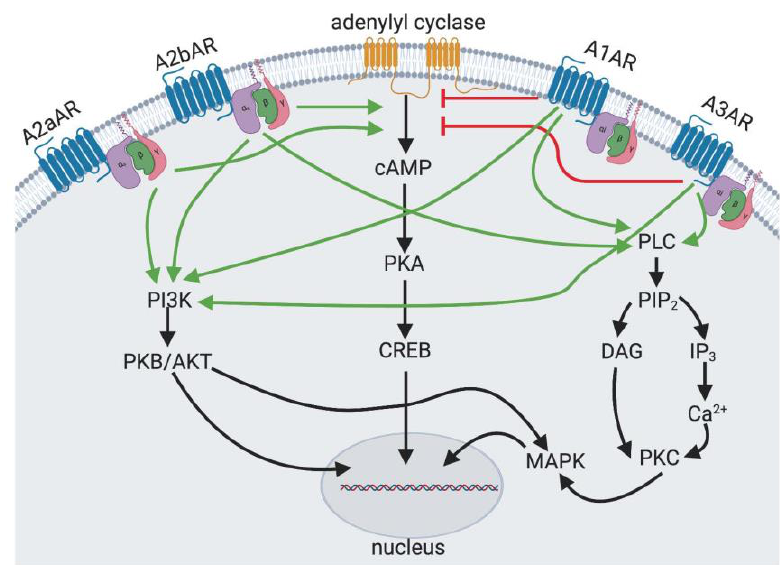
Figure 1. Adenosine Receptor Signaling. The A2aAR and the A2bAR are adenylyl cyclase stimulating receptors through G α s subunit. The A1AR and the A3AR are adenylyl cyclase inhibitory receptors through G α i subunit. The A1AR, A3AR and A2bAR also act through phospholipase C (PLC) to increase cytosolic calcium and diacylglycerol (DAG) to activate protein kinase C (PKC) and MAP kinase (MAPK) signalling. All adenosine receptors are capable of activating phosphatidylinositol 3-kinase (PI3K).